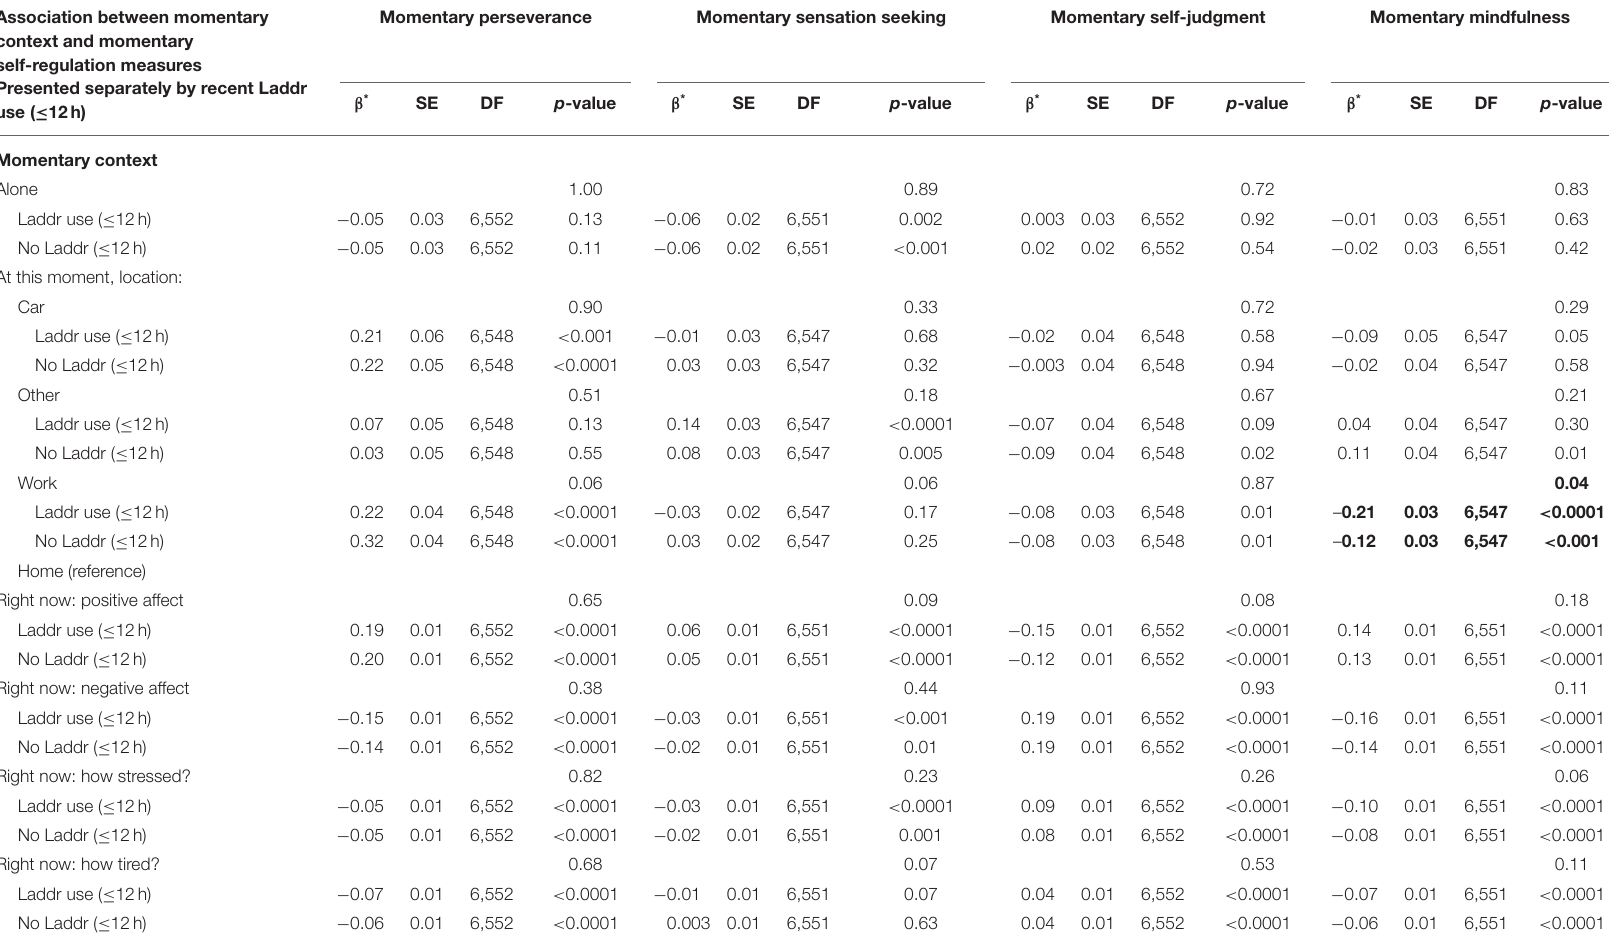
TABLE 4 | Momentary context measures, association with momentary self-regulation by recent Laddr use ( ≤ 12h) in the combined sample. Association between momentary context and momentary self-regulation measures Presented separately by recent